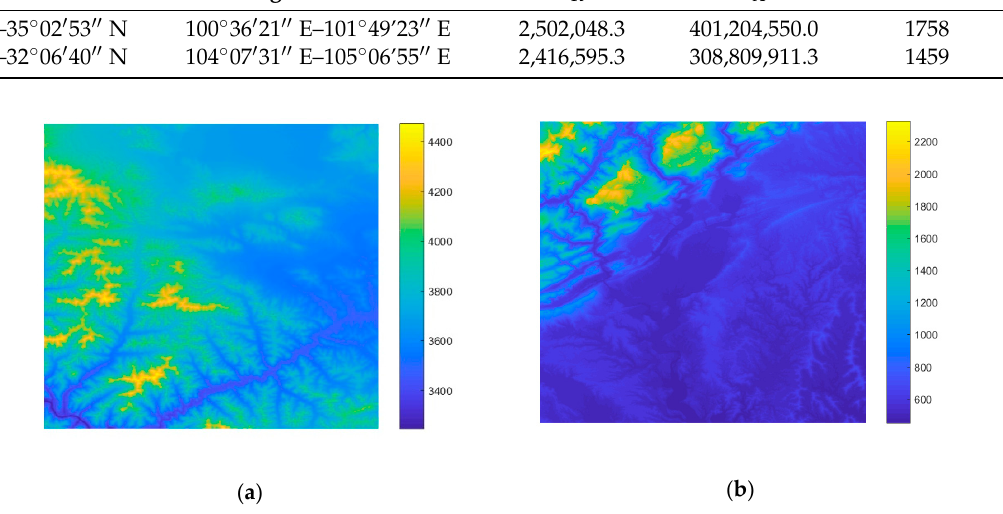
Table 1. Two DEMs for the experiments [28]; S R and S A denote relative and absolute configurational entropy, respectively. DEM DEM Latitude Extent